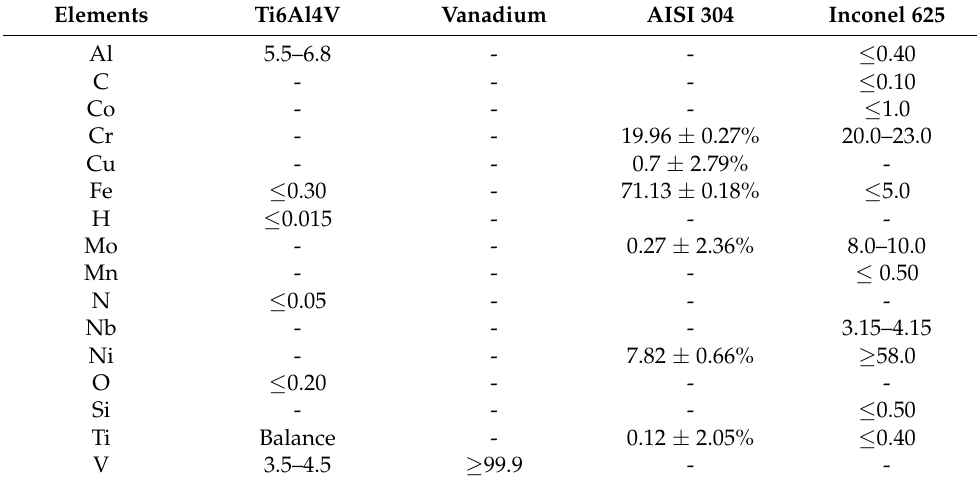
Table 1. Nominal chemical compositions (wt%) of Ti6Al4V, Vanadium, and Inconel 625. Chemical composition (wt%) with percentage error of AISI 304 measured by XRF.